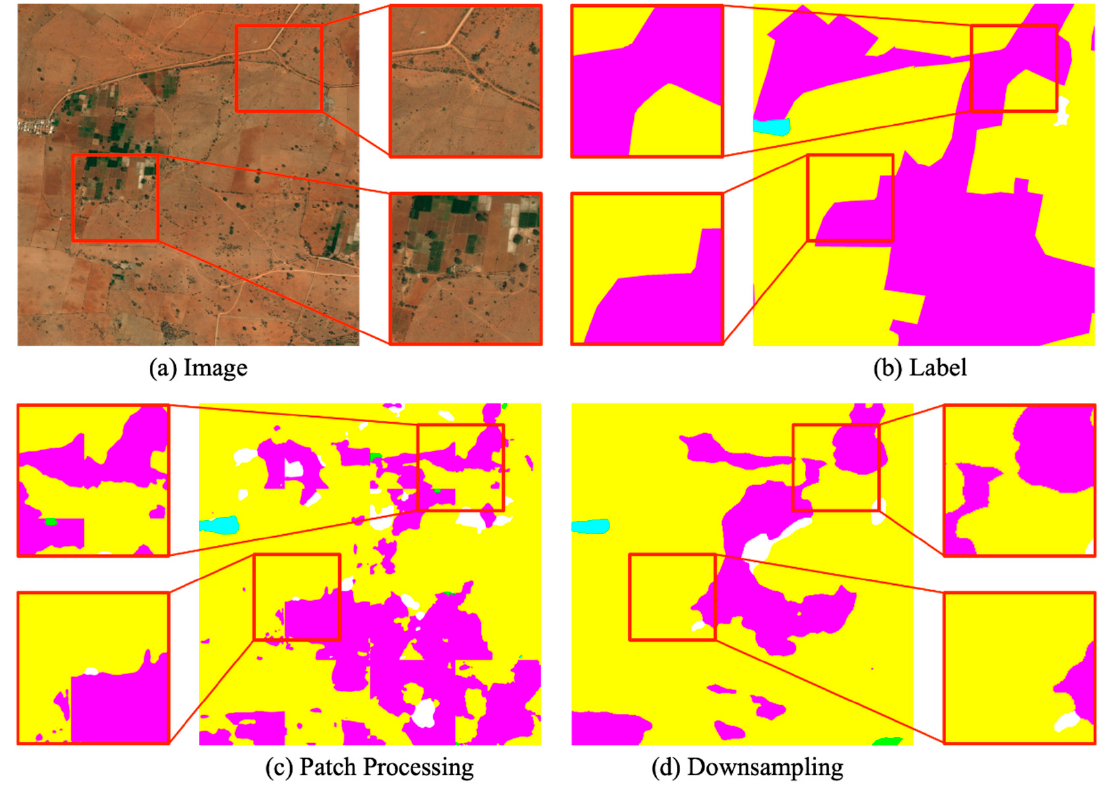
Figure 1. Results of semantic segmentation using patch processing and down-sampling processing. ( a ) is the input image and ( b ) is the labeled image, where the area circled in red contains two highly confusing categories-Agriculture and Rangeland. ( c , d ) represent the two processing methods respectively. As can be seen from the figures, down-sampling loses fine details, while patch processing wrongly classifies local patches due to the lack of the global context.